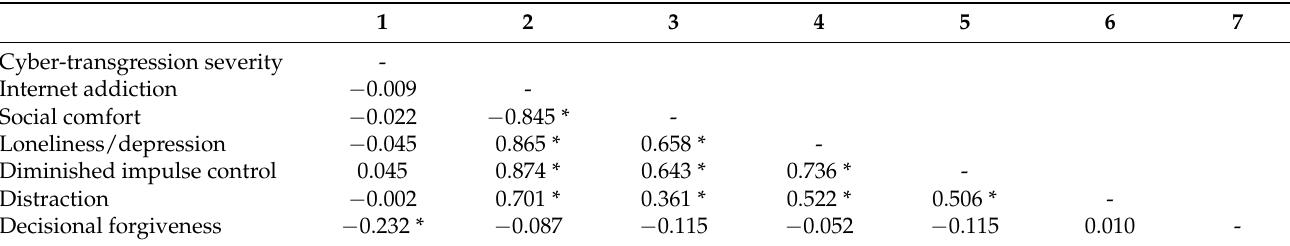
Table 1. Intercorrelations (Pearson’s r) between analyzed